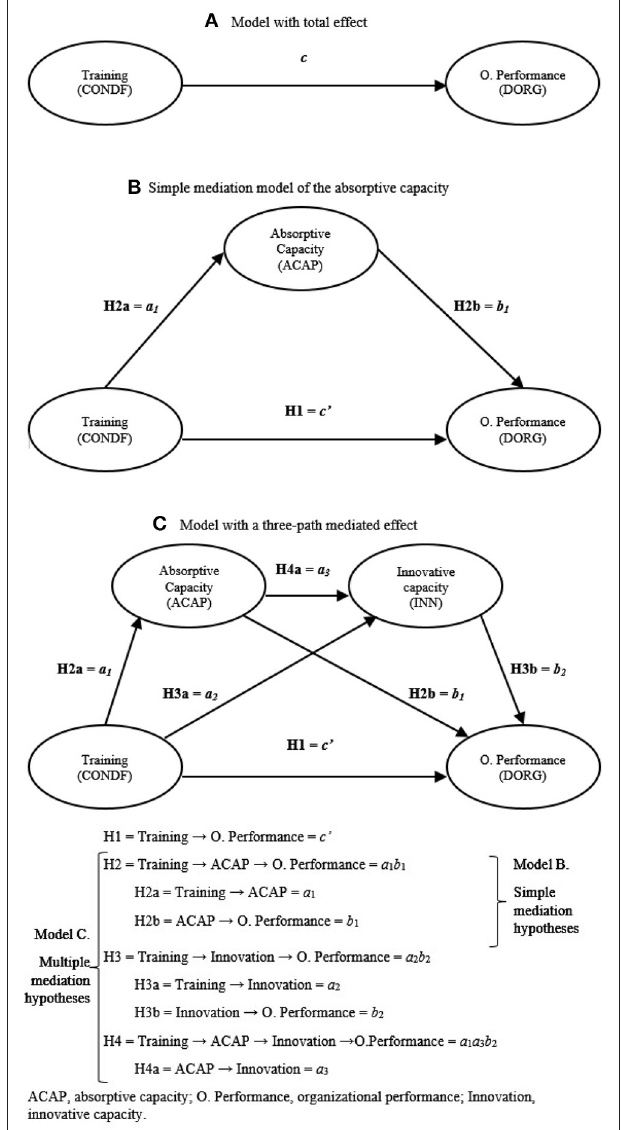
FIGURE 1 | Multiple mediating conceptual model. (A) Model with total effect. (B) Simple mediation model of the absorptive capacity. (C) Model with a three-path mediated